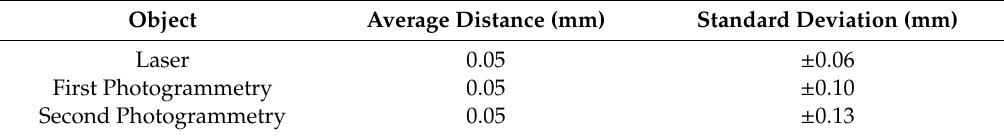
Table 2. Statistical indices obtained as a result of global alignments of the three datasets.